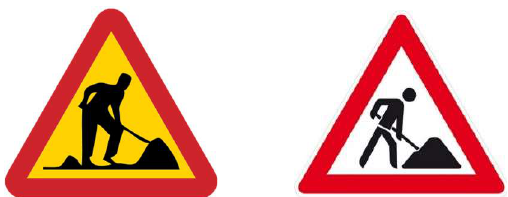
Figure 5. The road work sign in the Mapillary database and in the Hungarian traffic